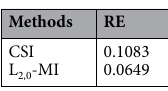
Table 1. The REs of different inverted impedance model.